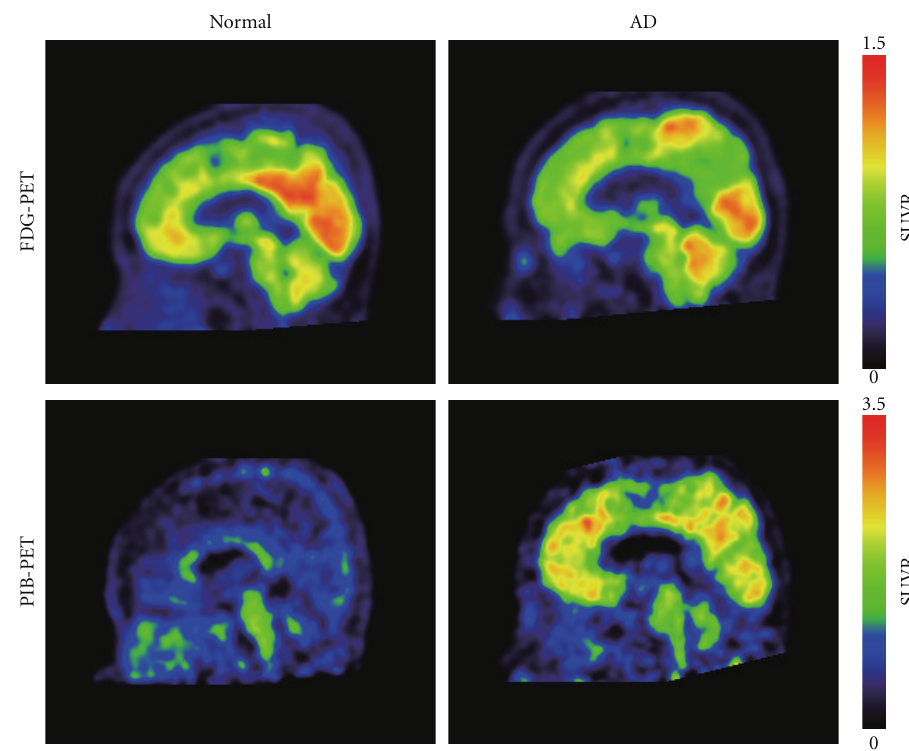
Figure 1: FDG and PIB-PET images of a representative normal elderly subject and an Alzheimer’s disease (AD) patient. (a) Positron emission tomography (PET) imaging of FDG in a normal 65-year-old man (left upper panel) and a 60-year-old woman with AD (right upper panel). (b) PET imaging of PIB in the same normal subject (left lower panel) and the same AD patient (right lower